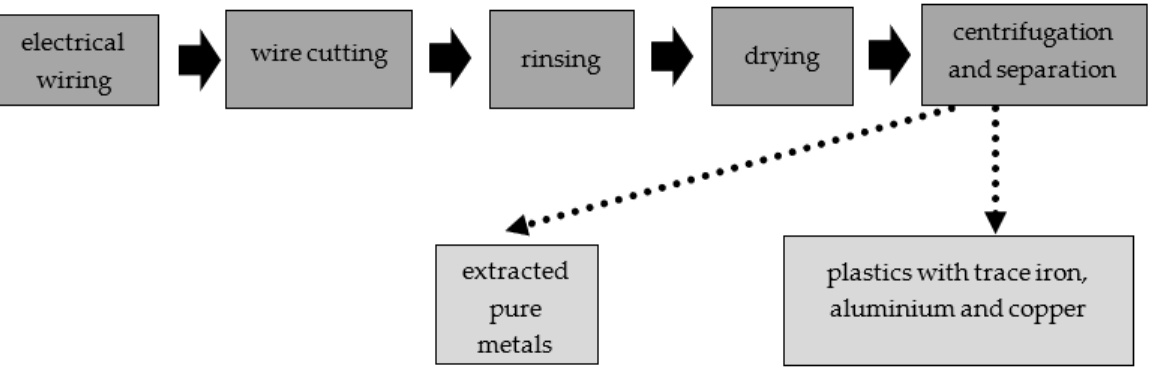
Figure 2. Waste material used to produce the LCF (( a ) particle size and structure; ( b ) transport and storage container). Figure 3. Step-by-step preparation of material for the active Figure 3. Step-by-step preparation of material for the active filling.